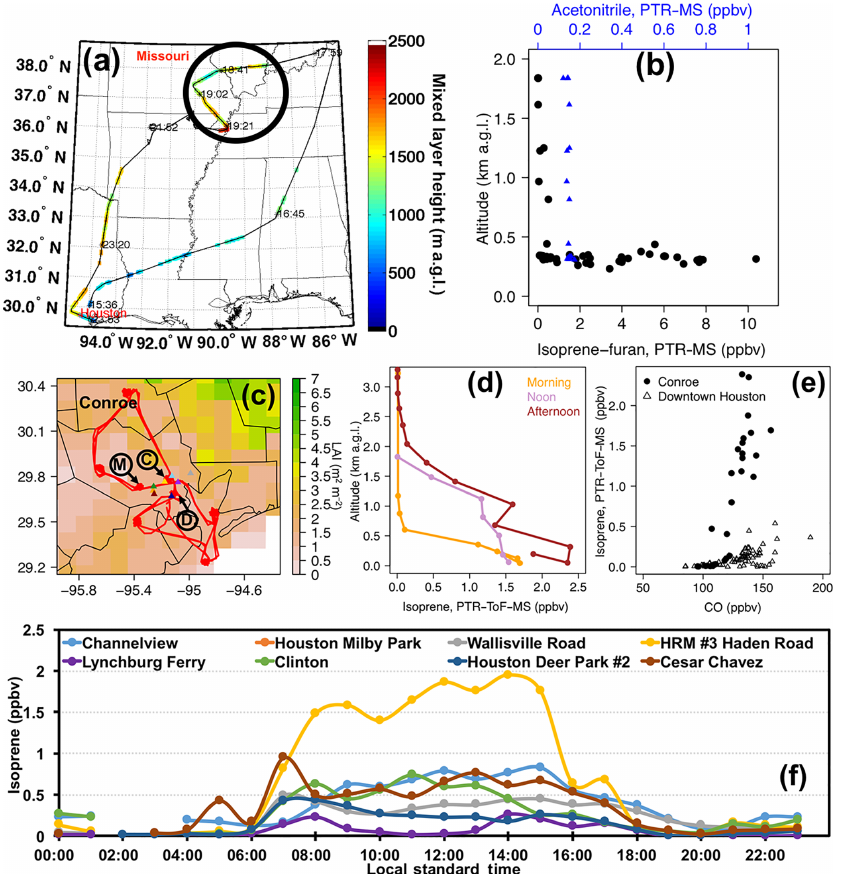
Figure 2. Measurements during the SEAC 4 RS campaign on 11 September 2013: (a) the DC-8 flight path colored by mixed-layer height from the DIAL–HSRL instrument. Areas within the black circle indicate the Missouri isoprene volcano regions sampled at ∼ 19:00UTC ( ∼ 13:00 local standard time). (b) Vertical profiles of the PTR-MS measured isoprene (black dots) and acetonitrile (blue triangles) at around the isoprene volcano regions. Measurements during the DISCOVER-AQ Houston campaign on 11 September 2013: (c) MODIS leaf area index (8-day mean with missing values filled with the monthly mean) over the Greater Houston area in the 12km NUWRF grid. The red solid line indicates the DISCOVER-AQ P-3B flight path. (d) Vertical profiles of the PTR-ToF-MS-measured isoprene at the Conroe spirals in the Greater Houston area at different times of the day. (e) Scatter plot of the P-3B measured isoprene–CO at the Conroe spirals (filled circles) and at three downtown Houston and Ship Channel sites of Moody Tower, Deer Park, and Channelview (open triangles), on 11 September 2013. Locations of Conroe, Moody Tower (M), Deer Park (D), and Channelview (C) are defined in (c) . The CO measurements were taken using a diode laser spectrometer for CO, CH 4 , N 2 O, with uncertainty of 2% or 2ppbv. (f) AutoGC isoprene measurements at multiple surface sites in Houston urban and ship channel areas. Locations of these sites are shown in (c) as colored triangles. Note that only one AutoGC data point is available at the Milby Park site at 00:00 local standard